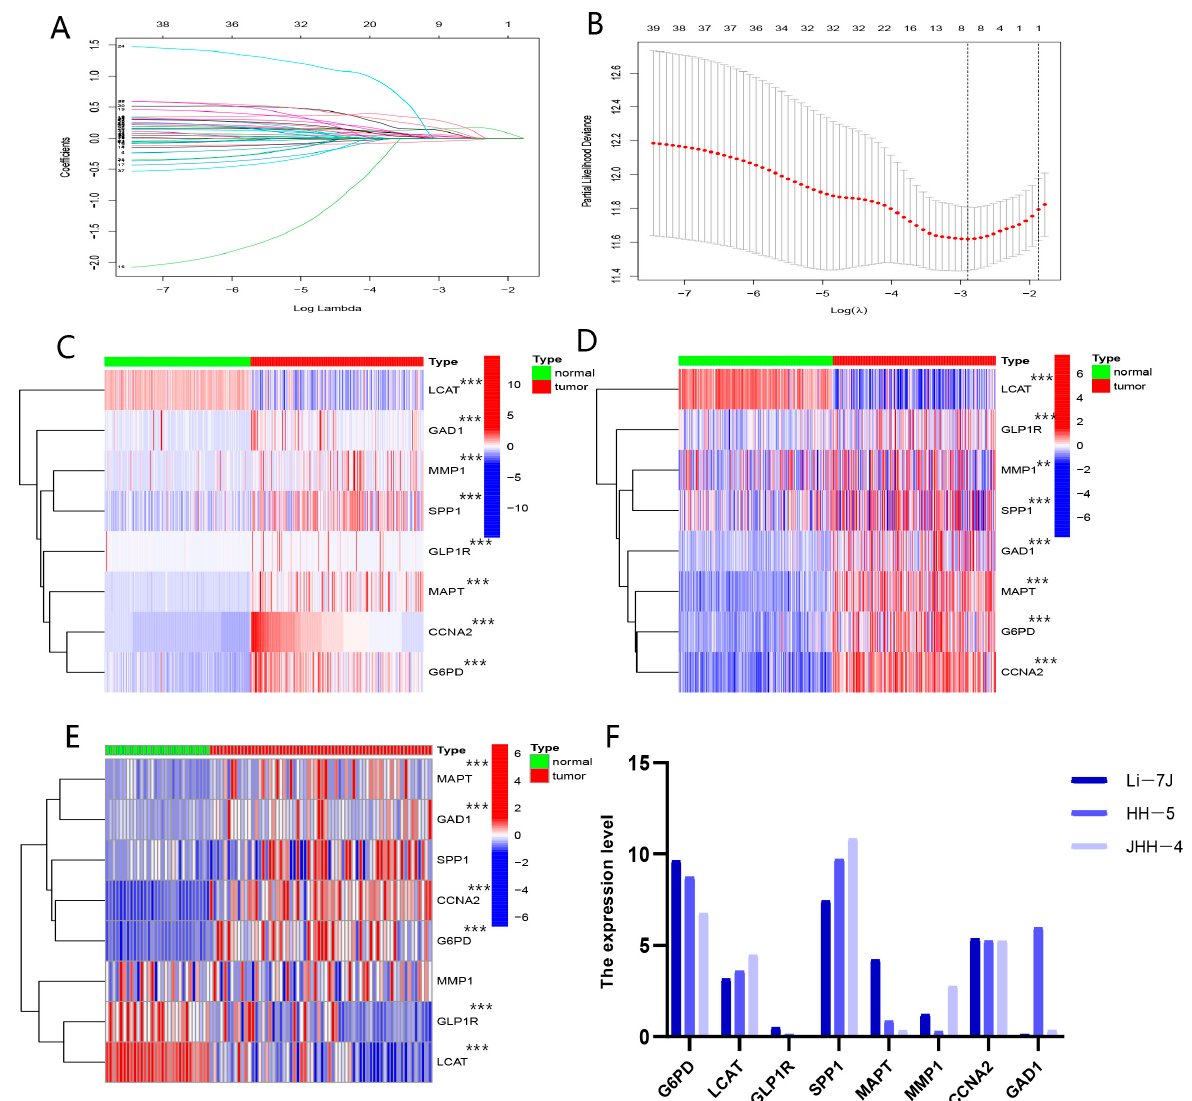
Figure 5. The procession of constructing the BMGs. ( A ) LASSO coefficient profiles. ( B ) Candidate genes were filtered by the LASSO algorithm. ( C ) Validation of the expression of the eight genes that make up the BMGs between HCC and normal tissues in ICGC-JP. ( D ) Validation of the expression of the eight genes that make up the BMGs between HCC and normal tissues in GSE25097. ( E ) Validation of the expression of the eight genes that make up the BMGs between HCC and normal tissues in GSE87630. ( F ) Validation of the expression of the eight genes that make up the BMGs in HCC cell lines in CCLE. (“**”, “***” represent p < 0.01, p < 0.001, respectively.).